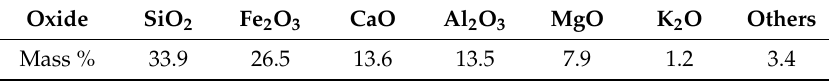
Table 1. X-ray fluorescence (XRF) analysis of fly ash.